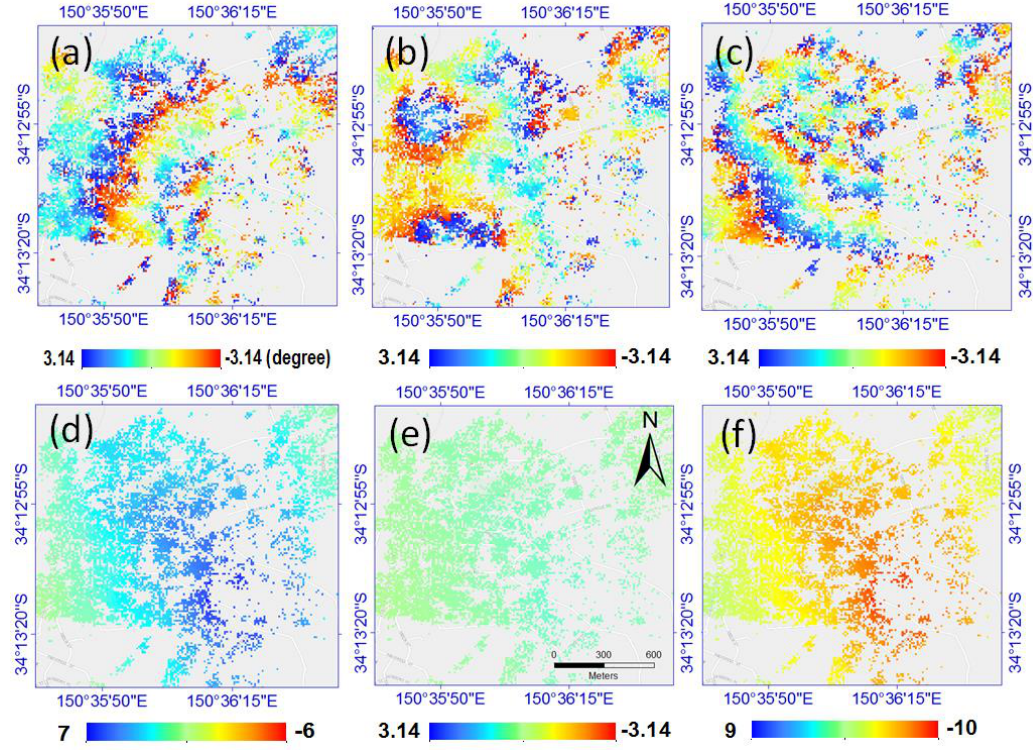
Figure 6. Three selected interfergrams within the study region of Figure 4. ( a – c ) interferometric phase after the interferometric phase optimization; ( d – f ) unwrapped phase from deformation; ( a , d ) 3 February 2008 and 18 January 2009; ( b , e ) 9 November 2008 and 18 January 2009; ( c , f ) 18 January 2009 and 1 August 2010.